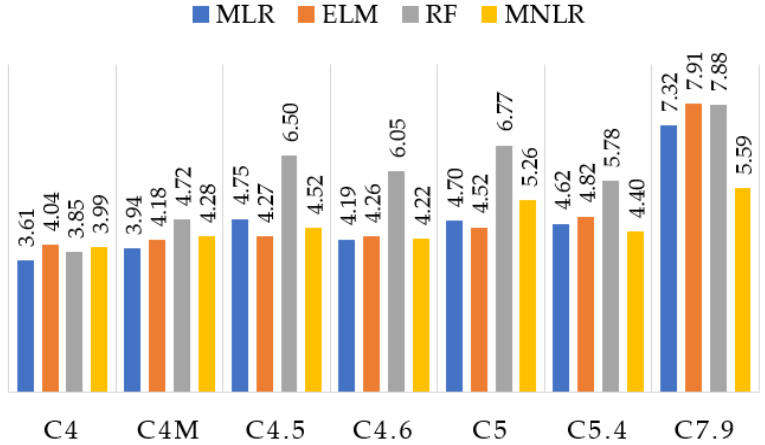
Figure 6. Predicted values of alcohol content (%) for each of the methods applied. Table 6. Predicted values and the RMSE of the test samples for each method.